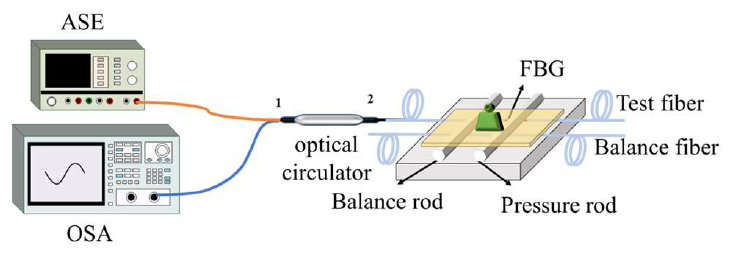
Figure 4. Schematic of the experimental setup.